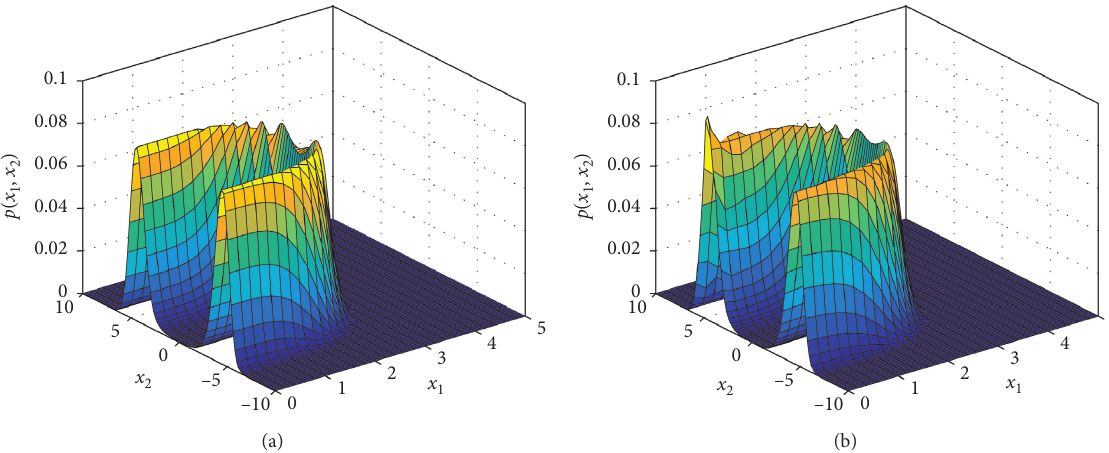
Figure 3: Stationary joint PDFs for displacement x